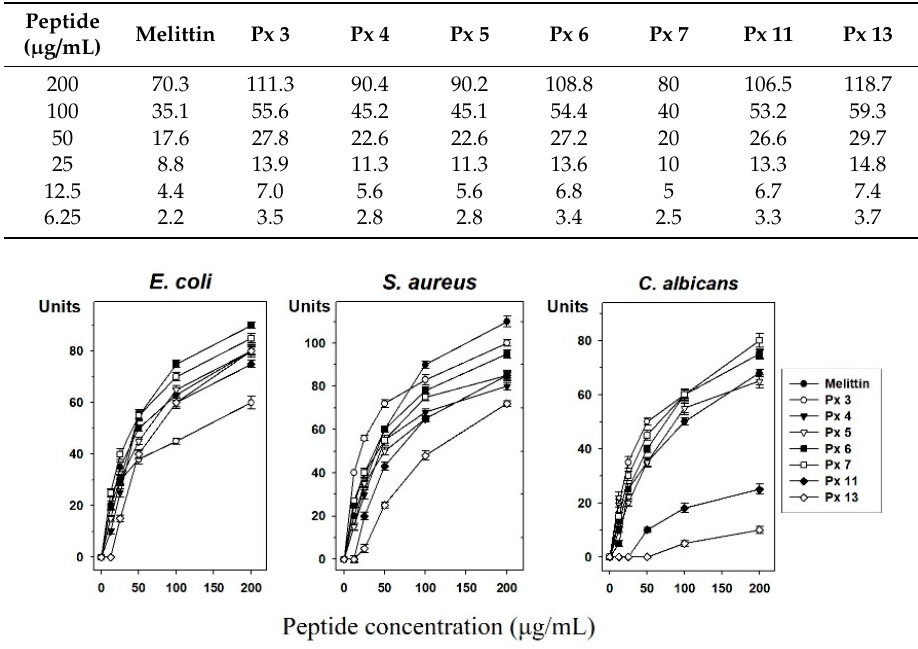
Figure 3. Antimicrobial activity assay. Antimicrobial activities of seven selected peptides against Escherichia coli, Staphylococcus aureus , and Candida albicans determined by a radial diffusion assay. Peptide concentration ( x -axis) was plotted against the diameter of the microbial growth inhibition zone ( y -axis) after incubation for 12 h and is expressed in units (1 mm = 10 units). Melittin was used as a positive control. Mean values were obtained from tests repeated three times.